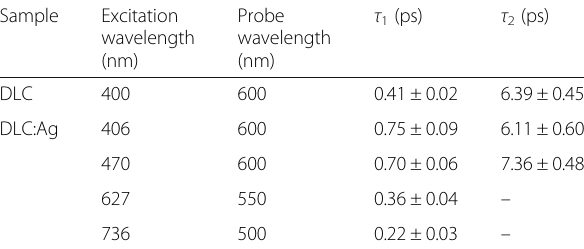
Table 1 Lifetimes of TAS spectra relaxation (the kinetics at 600 nm probe wavelengths are presented because they demonstrate best